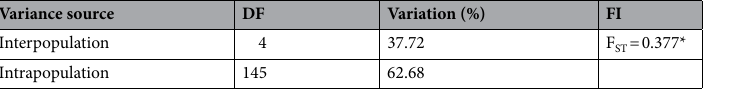
Table 3. Analysis of Molecular Variance (AMOVA) of S. terebinthifolia in five ecoregions of the Atlantic forest biome. DF degree of freedom, FI fixation index. *P <